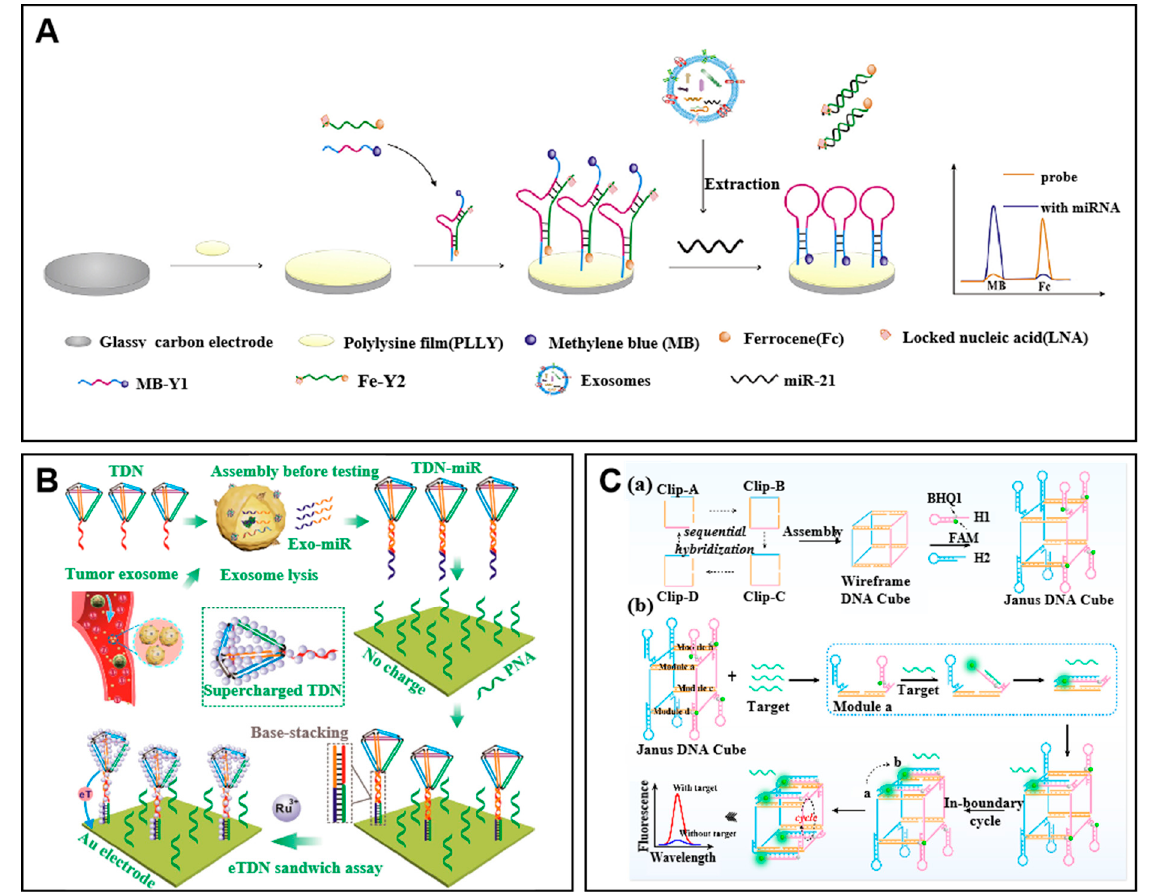
Figure 1. Examples of assembled DNA capture probes. ( A ) Schematic of the Y-shaped structure-based ratiometric electrochemical biosensor for the detection of exosomal miR-21. Adapted with permission from [48]. Copyright 2019 Elsevier. ( B ) Schematic of the tetrahedral DNA nanostructure (TDN)-based DNA capture probes for target exo-miRNA capturing. After formation of the TDN–miR complex, the PNA hybridizes with the complex as a sandwich constructed on a gold electrode for further sensing. Adapted with permission from [50]. Copyright 2021 American Chemical Society. ( C ) Schematic of the fluorescent sensor for detection of exo-miRNA based on Janus wireframe DNA cube. (a) The procedure of Janus wireframe DNA cube assembly. (b) The reaction of the 3D nanomachine. Adapted with permission from [51]. Copyright 2022 Elsevier.